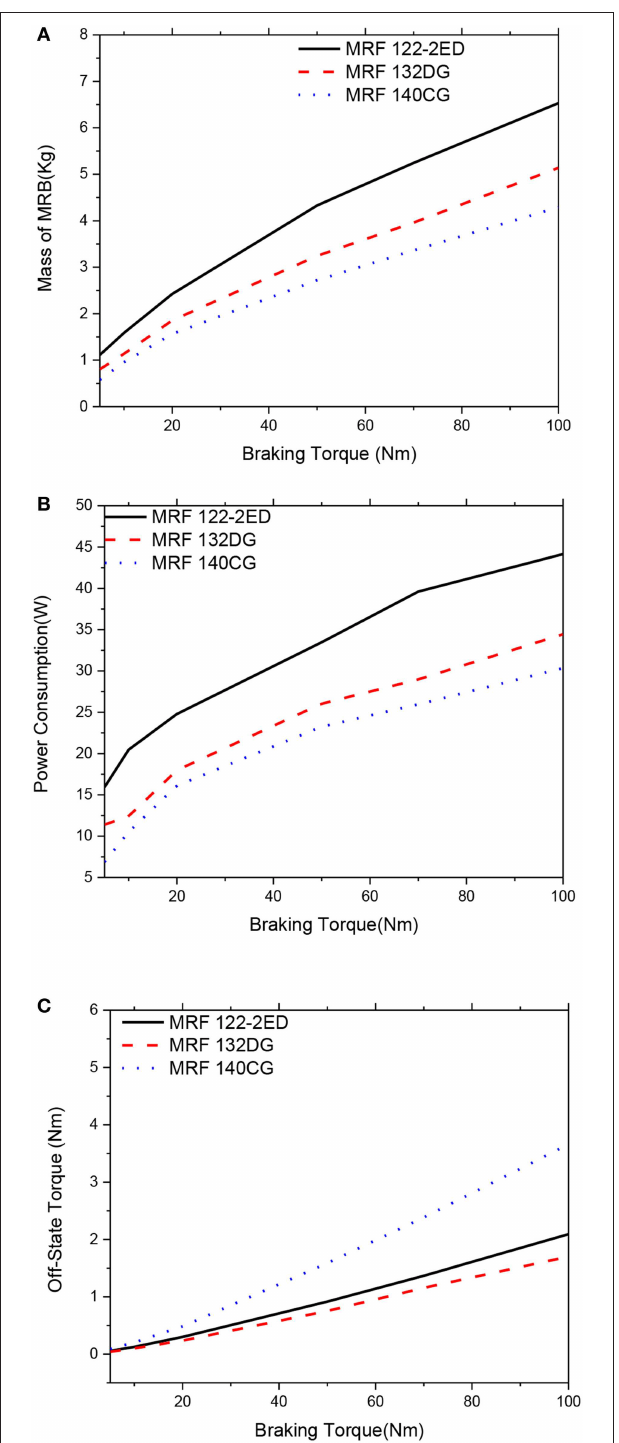
FIGURE 17 | Multi-objective optimization results of the MRBs as a function of braking torque of side-coil MRB, α m = 0.5 ; α P = 0.0 ; α To = 0.5. (A) Mass as a function of braking torque, (B) Power consumption as a function of braking torque, (C) Off-state torque as a function of braking torque.